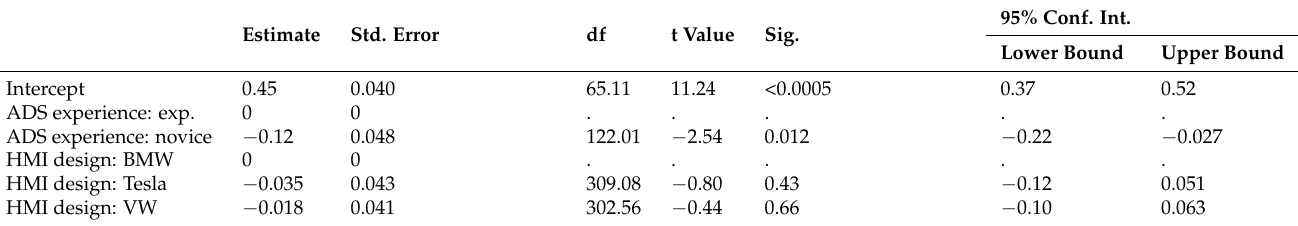
Table 3. Estimates of fixed effects for the mixed effect